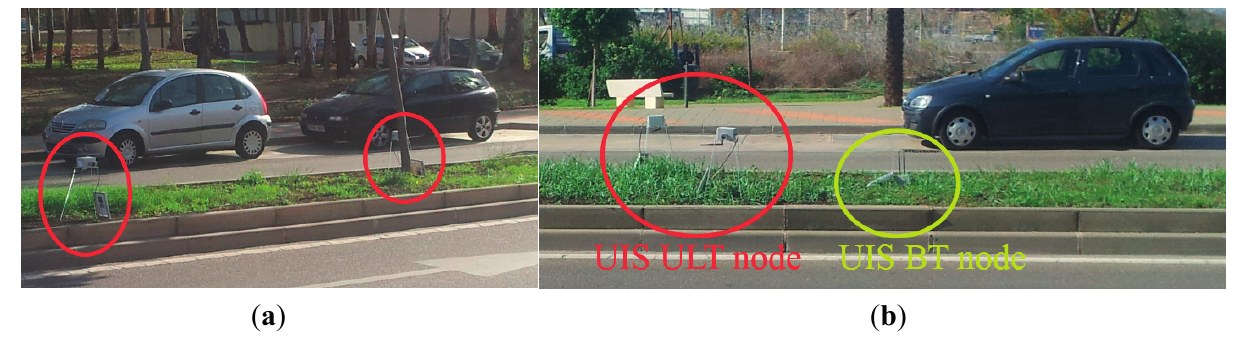
Figure 22. Some UIS nodes in a real experiment. ( a ) UIS nodes in roundabout I; ( b ) UIS nodes in roundabout II.